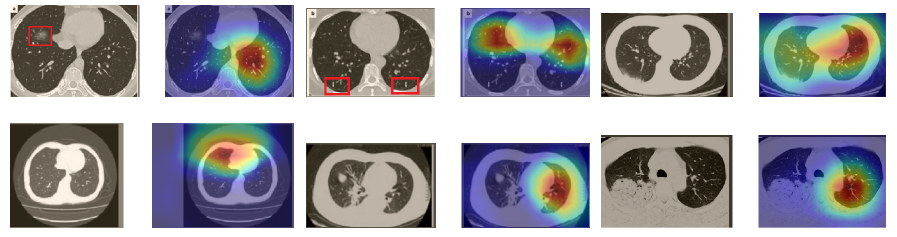
Figure 18. CT scans and their Grad-CAM localization maps showing cases in which the model failed to localize the most relevant COVID-19